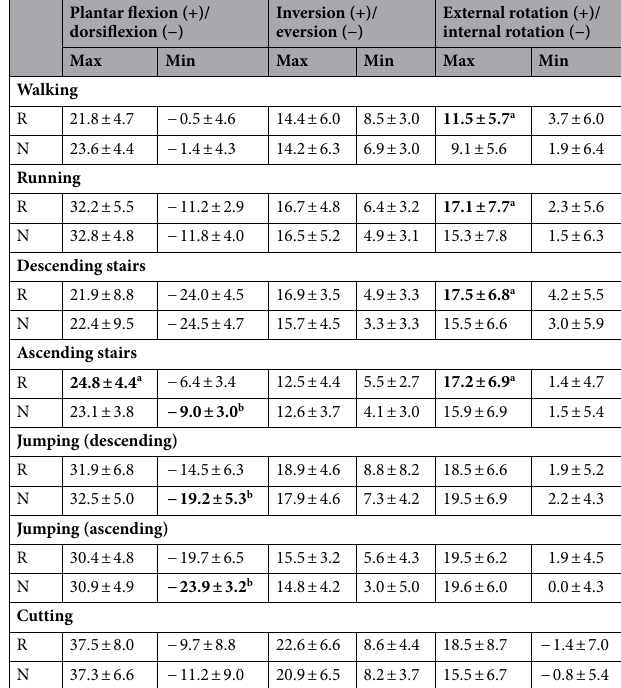
Table 1. Extreme ankle joint angles (°) in three motion planes during six functional movements (mean ± standard deviation). N normal shoes, R rocker-soled shoes. a Represents an angle for rocker-soled shoes that is significantly larger than for normal shoes ( p < 0.007). b Represents an angle for normal shoes that is significantly larger than for rocker-soled shoes ( p < 0.007). Significant values are in